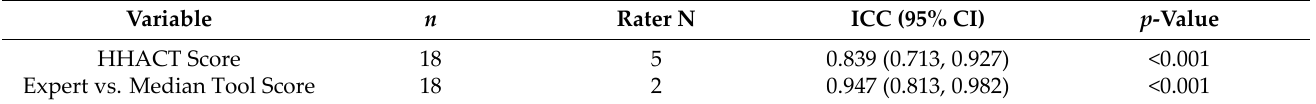
Table 3. Reliability HHACT scores using intraclass correlation.